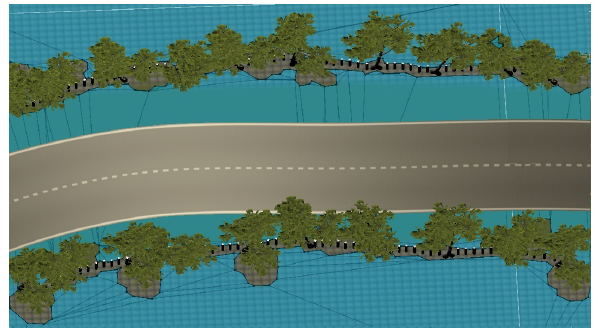
Figure 3. Accessible area for a car presented in blue without considering the road.